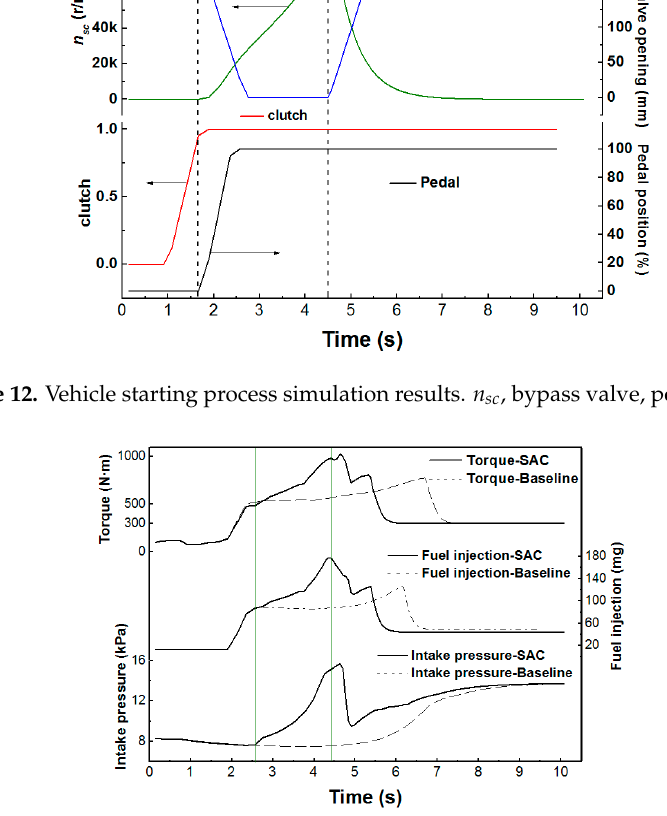
Energies 2017 , 10 , 689 Figure 13. Vehicle starting process simulation results. Torque, Fuel injection and Intake pressure.